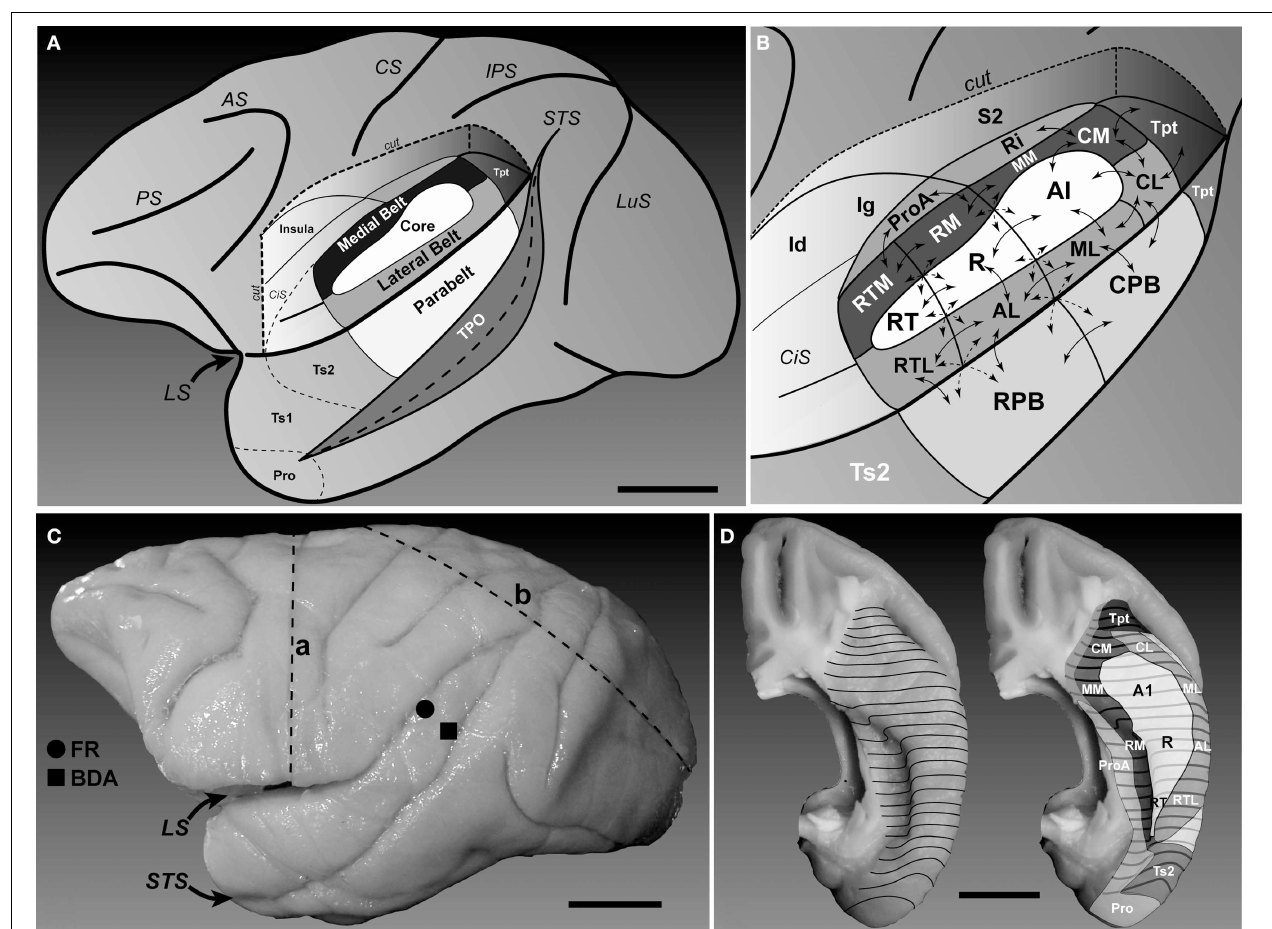
FIGURE 1 | Location and subdivisions of the auditory cortex in macaque monkeys. (A) Lateral view of the left hemisphere showing position of auditory and auditory-related regions in the superior temporal region. The parabelt region is located on the surface of the superior temporal gyrus (STG). The core and belt regions lie on the superior temporal plane, visible after graphical removal of the overlying parietal and frontal opercula (cut). Area TPO lies on the upper bank of the superior temporal sulcus. The locations of the areas on the STG rostral to auditory cortex (Ts2, Ts1, and Pro) are also labeled (after Galaburda and Pandya, 1983). (B) Location and connections of areas within and around auditory cortex (see list of abbreviations for details). Core region : A1, R, RT; Medial